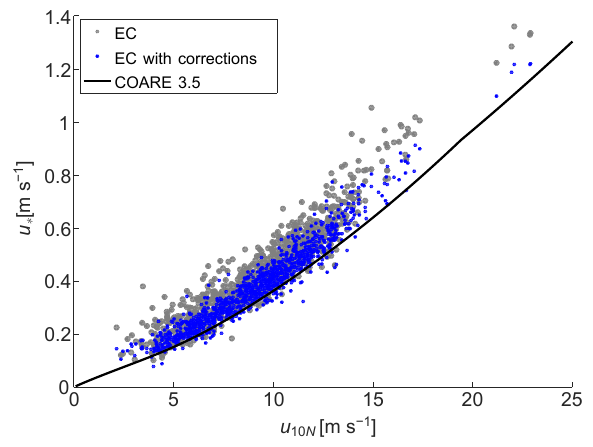
Figure 4. Eddy covariance estimates of u ∗ as a function of u 10N , estimated from the airflow distortion corrected wind speed mea- sured by bow mast anemometers. The COARE 3.5 open-ocean re- lation (Edson et al., 2013) is shown as a black